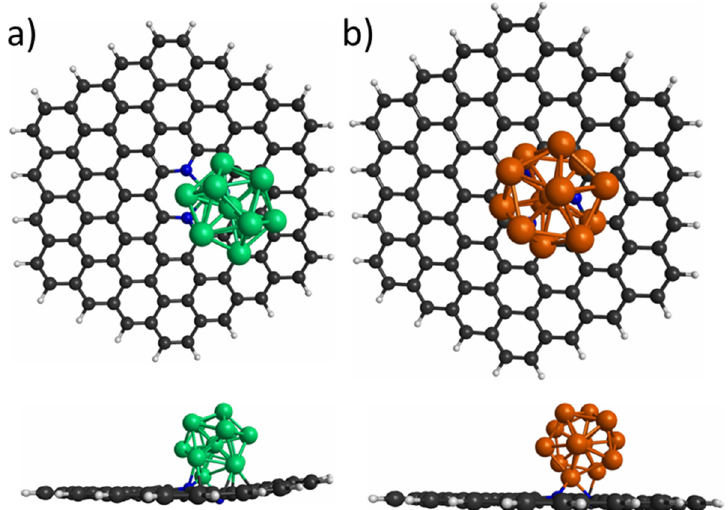
Figure 2. Top and side views of the most stable interaction of ( a ) Co 13 and ( b ) Cu 13 nanocluster deposited on pyridinic N 3 -doped graphene. Green, orange, black, white, and blue spheres represent Co, Cu, C, H, and N atoms, respectively.